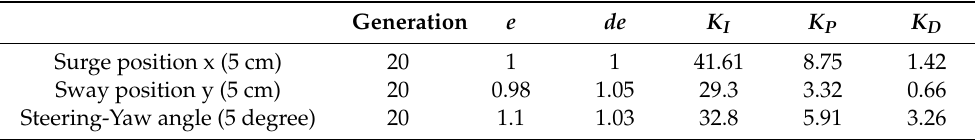
Figure 6. ( Top ) Sway—position control; ( bottom ) improved GA (mGA) versus standard GA (sGA) fitness functions. Table 2. The fuzzy-PID-mGA tuning results.